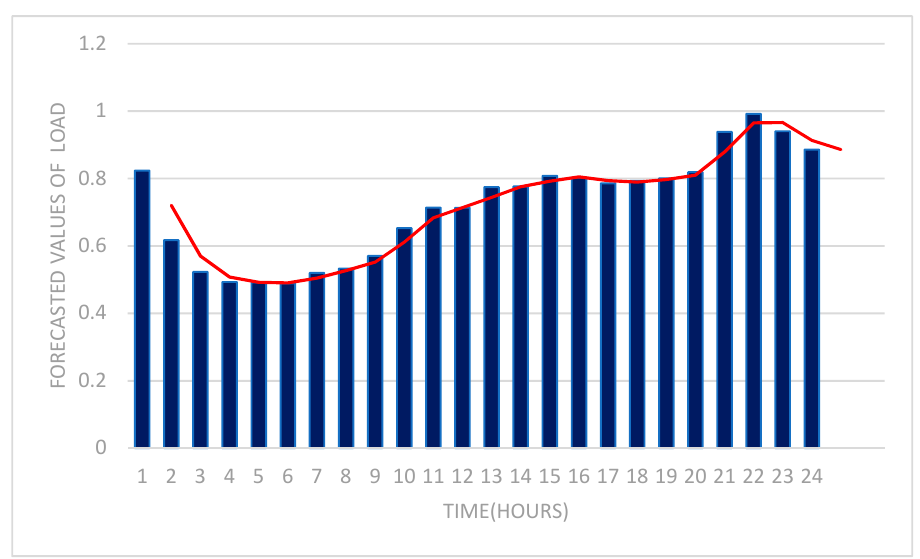
Figure 5. Default load demand curve.